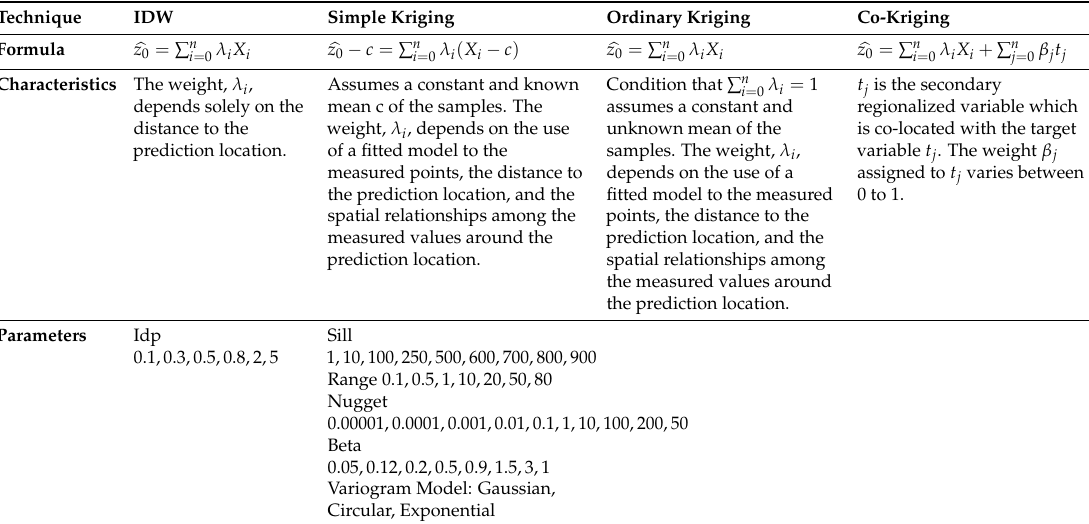
Table 2. Techniques Used for Outdoor Pollution